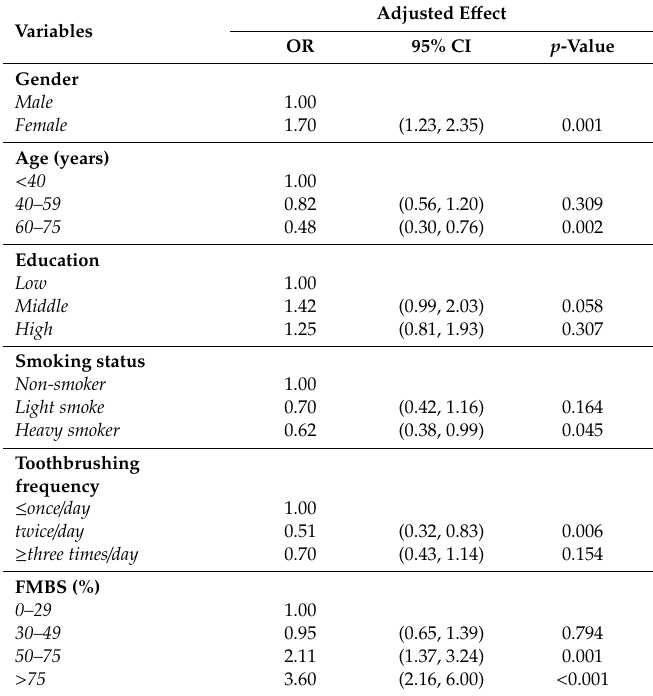
Table 3. Multivariate logistic model, considering self-awareness of gingival bleeding as the outcome variable (Hosmer and Lemeshow χ 2 = 11.934, df = 8, p = 0.154).